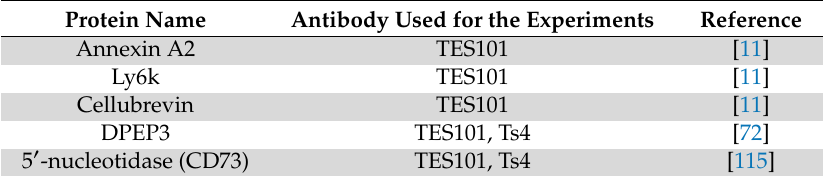
Table 3. Possible proteins associated with TEX101 within the